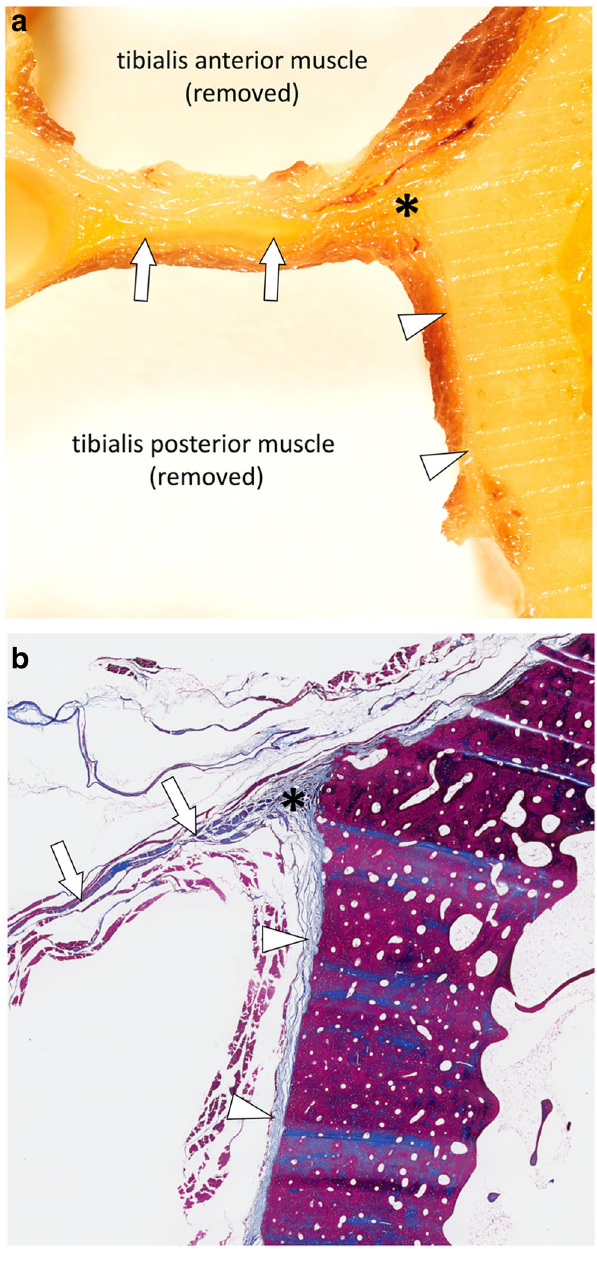
Fig. 6 a Close-up photograph and ( b ) photograph of the corre- sponding microscopic image (Masson ’ s trichrome stain) of the deep posterior compartment and lateral part of the tibia (green square in Fig. 1). The deep intermuscular fasciae (arrows) be- tween the tibialis anterior and tibialis posterior muscles are in continuity (asterisks) with the periosteum of the tibia (arrowheads)